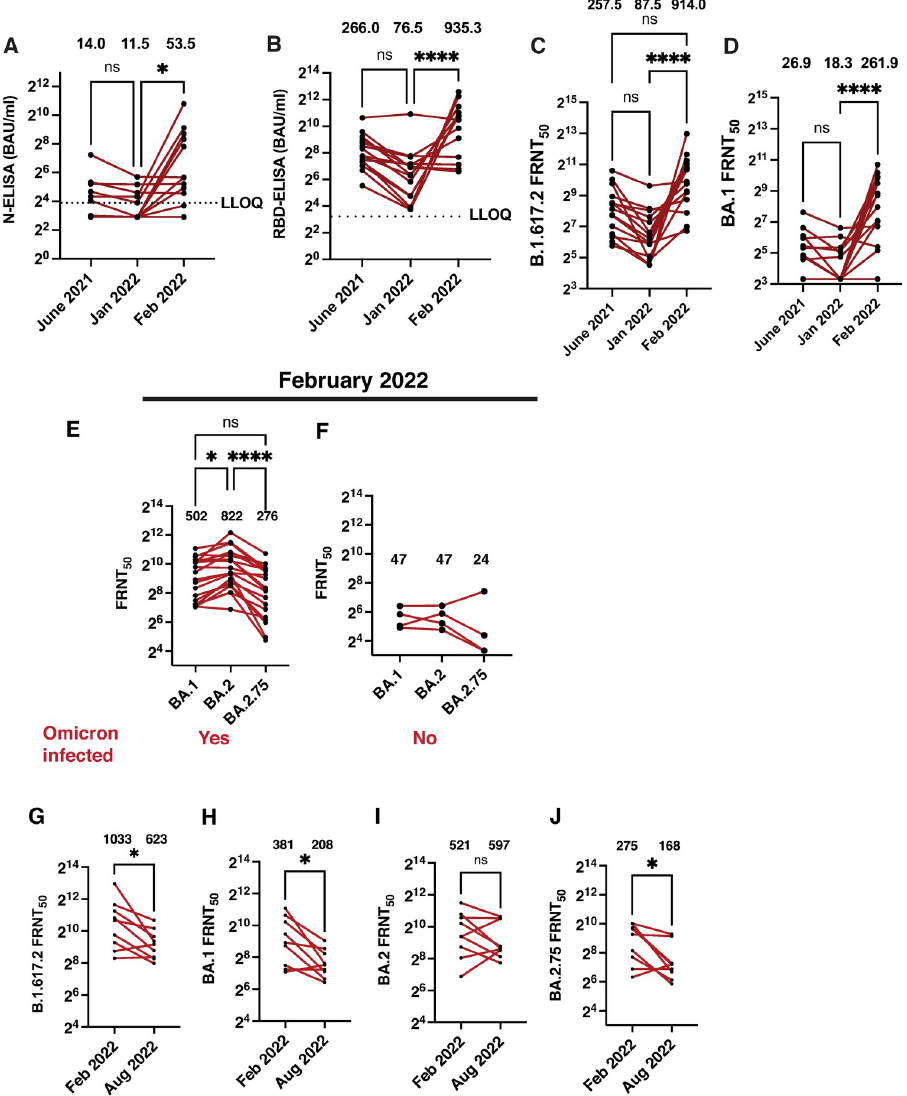
Fig 6. Omicron infection induces cross-protective antibodies. (A) Binding antibodies to nucleocapsid (N) and (B) RBD were estimated by quantitative ELISA for the three time-points post-vaccination as indicated (n = 15). (C) Neutralizing antibody titers to Delta variant and (D) Omicron variant was determined in the same samples by FRNT assay. Statistical significance was estimated by Kruskal-Wallis test with Dunn’s multiple comparison test. ns: not significant. � P < 0.05, ���� P < 0.0001. (E) Neutralizing antibody titers to the BA.1, BA.2 and BA.2.75 sub-lineages were determined in samples from participants that were infected with Omicron variant in early 2022 (n = 20) and (F) indicates the same in individuals unexposed to the Omicron variants (n = 4). Numbers indicate the geometric mean NT50 values. Statistical significance was estimated by paired analysis using Friedman test with Dunn’s multiple comparison test. ns: not significant. � P < 0.05, ���� P < 0.0001. Paired analysis for neutralizing antibodies in six month follow-up convalescent samples which were tested for neutralization of (G) Delta variant, (H) BA.1 (I) BA.2 and (J) BA.2.75. P values were obtained by Wilcoxon matched-pairs signed rank test. � P < 0.05. ns: Not significant.